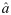
Rod rhodopsin measurement (I) and Blood vessel detection.We determined b ≈ 0.04 through the largest count in the histogram, which corresponds to the fit associated to an average of a large annulus area. The gradient descent minimization scheme led to the optimized parameters a^ and c^, where the macular pigment distribution was used to refine the initial value a
0. Blood vessels show up as artifacts in the resulting rhodopsin maps and must still be removed.We detect blood vessels through a scheme that evolves from the computational minimization of E related to the rhodopsin model. Spatial regions where the numerical algorithm converges significantly slower than in other image parts shall be identified as blood vessels. The number of required iterations leads to an image which can simply be thresholded to identify retinal blood vessels.(a) spatial map of parameter c^ optimal within the model. Brighter means increase in rhodopsin density, but brightest spots occur as registration artifacts along blood vessels. Therefore, the grayscale colormap is suppressed.(b) extracted mask of blood vessels derived from thresholding the number of iterations needed for convergence in the optimization scheme. Simple pixel growth in the mask would lead to complete coverage of the vessels.